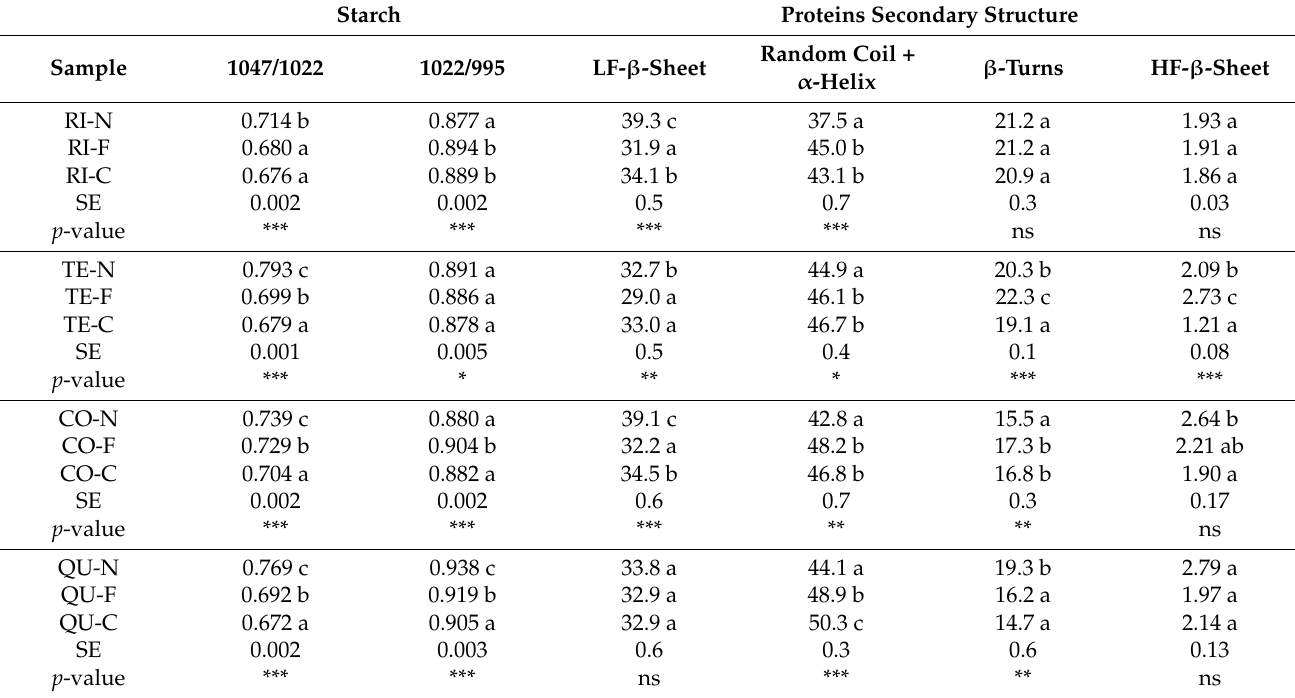
Table 3. Analysis of starch and protein secondary structure on native and treated flours using FTIR. Starch Proteins Secondary